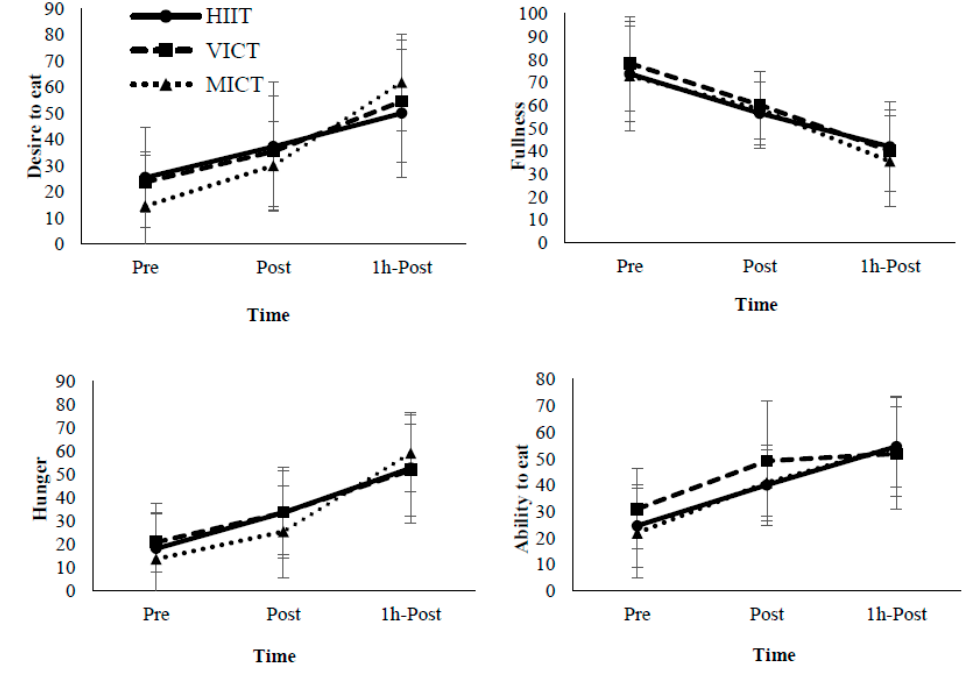
Figure 3. Appetite Sub-Score Analysis. Pre: Immediately pre-exercise; Post: Immediately post-exercise; 1h-Post: 1-h post-exercise.